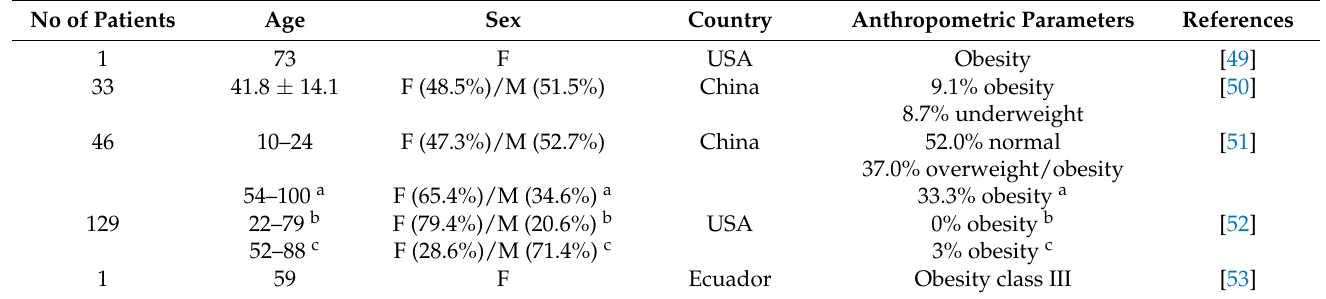
Table 4. Summary of articles with data indicating obesity, but not BMI, and patients affected by COVID-19. No of